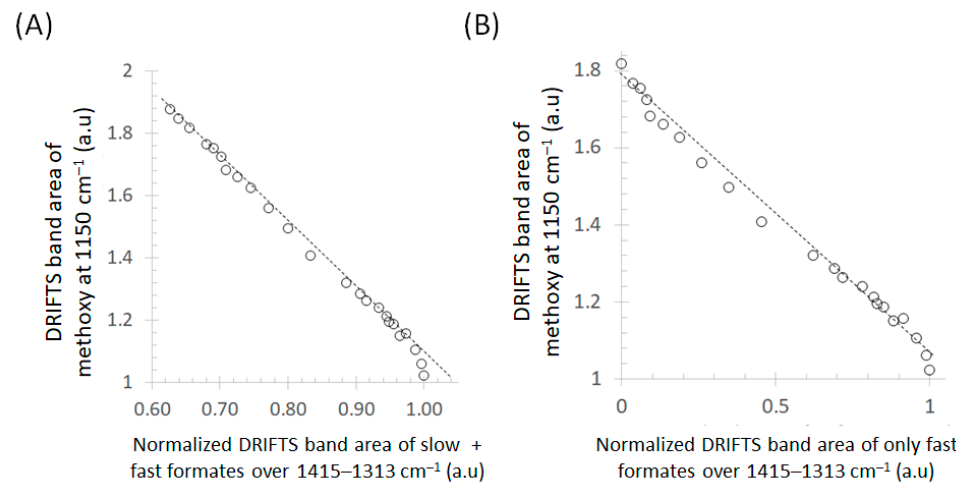
Figure 6. Variation of the methoxy DRIFTS band area at 1150 cm − 1 as a function of that of the formate band following the removal of CO 2 . Feed: 100 mL min − 1 of 85% H 2 /He.